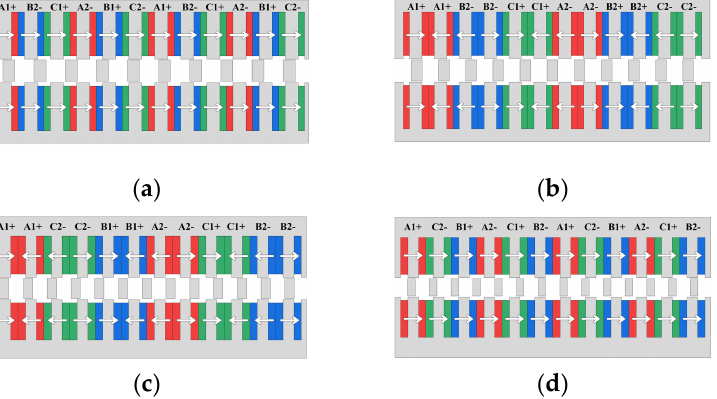
Figure 3. Multi-objective optimization of DCB-VRLMs using NSGA-II algorithm. Figure 3. Multi ‐ objective optimization of DCB ‐ VRLMs using NSGA ‐ II algorithm.